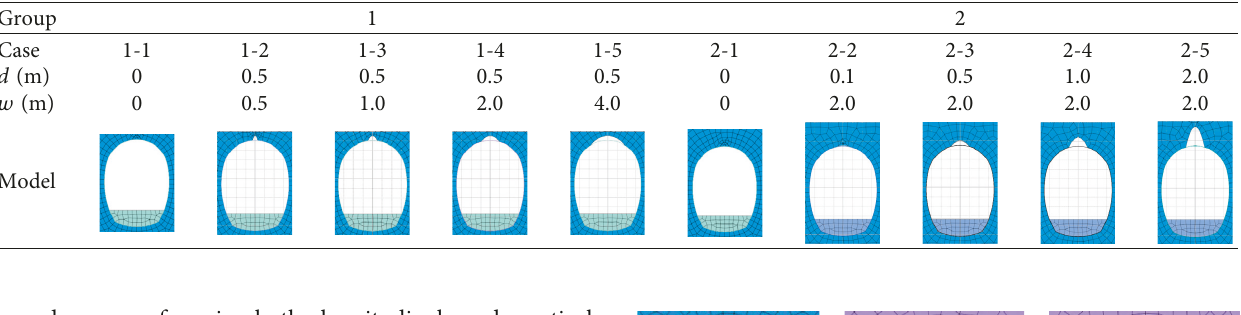
Table 1: Cases in groups 1 and